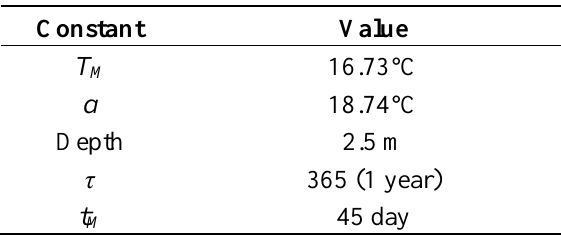
Table 3. Values of the constant used in Equation (1).